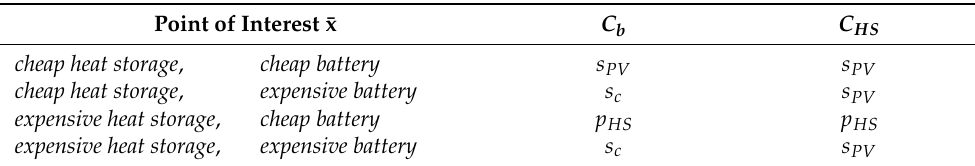
Table 3. The most relevant interpretable features for cost-optimal battery capacity C b and heat storage capacity C HS . Interpretable features are the cloud size s c , the number of clouds n c , the storable PV surplus s PV , specific battery investment costs p b , morning mist m m , and specific heat storage investment costs p HS . C b C